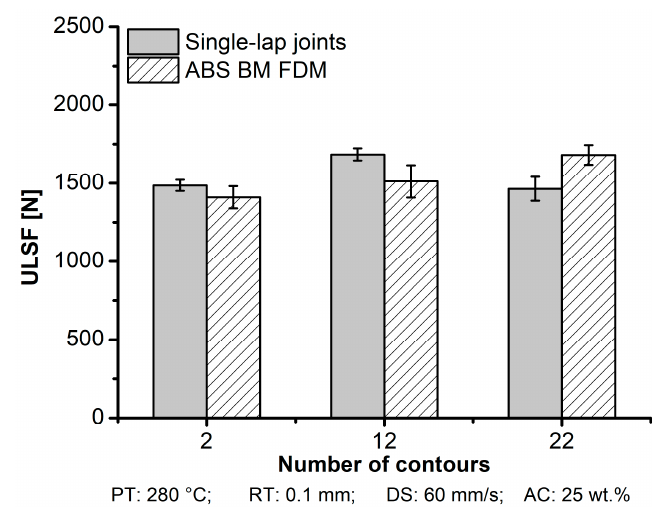
Figure 22. Influence of the number of contours on ULSF for the aluminum 2024-T3/ABS hybrid joints (single-lap joints) and ABS BM FDM (condition nine, NC: 2; condition ten, NC: 12; condition eleven, NC: 22; the following parameters PT: 280 °C, RT: 0.1 mm, DS: 60 mm/s, and AC: 25 wt.% were fixed